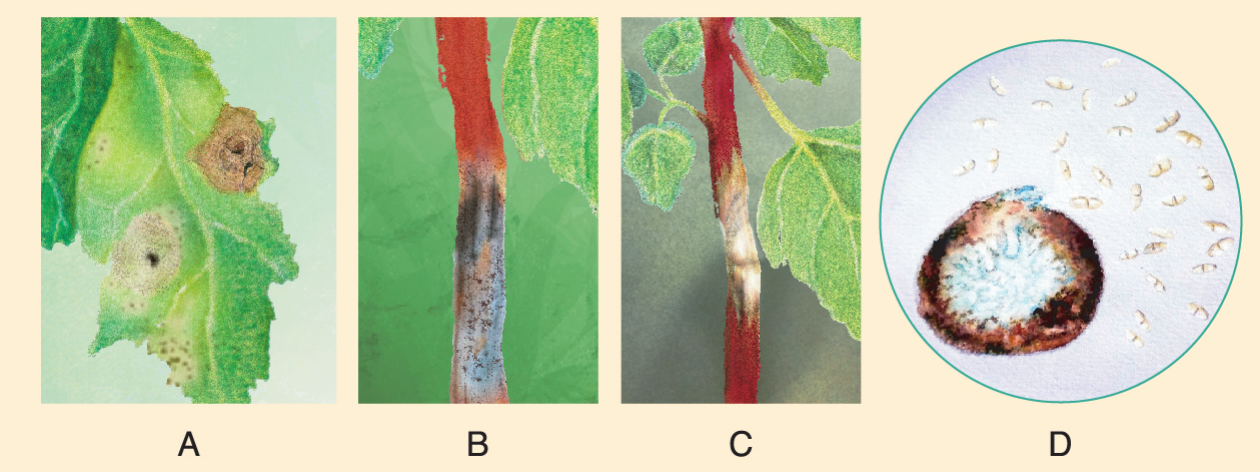
Figure 14. Typical symptoms of quinoa black stem in the fields of China. ( A ) Symptoms induced by inoculation of A. caulina on C. quinoa (left of midrib) and on C. album (right of midrib). ( B ) 10 dpi diamond shaped lesion on quinoa stem with presence of pycnidia. ( C ) Necrotic quinoa stem prior to lodging; ( D ) morphological characteristics of conidia and pycnidia of A. caulina . Source: illustrations based on pictures from Yin et al.